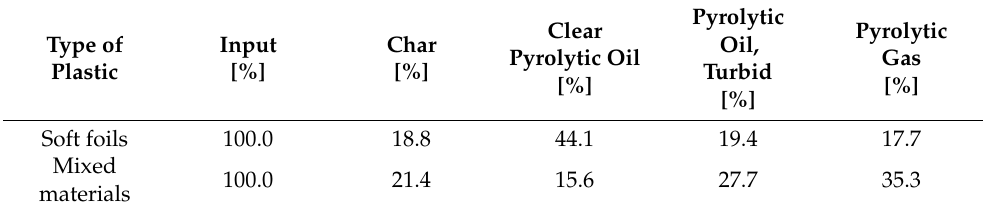
Table 2. Results of mass balance calculations.